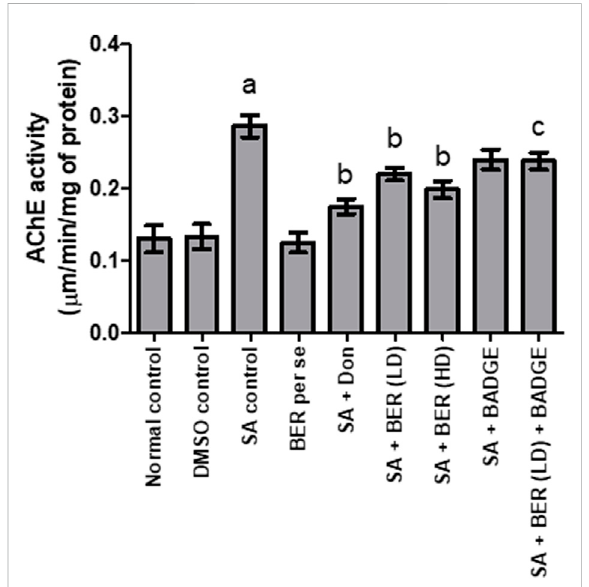
FIGURE 3 Effect of pharmacological interventions on brain AChE activity ( μ M of ACh hydrolyzed/min/mg protein). “ DMSO, dimethyl sulfoxide; SA, sodium azide; Don, donepezil; BER, bergenin; BER (LD), bergenin low dose; BER (HD), bergenin high dose; BADGE, Bisphenol A diglycidyl ether ” (Mehra et al., 2015). “ Each group ( n = 6) represents mean ± S.E.M, a = p ˂ 0.05 vs. normal control, b = p ˂ 0.05 vs. normal control, c = p ˂ 0.05 vs. SA control. One way ANOVA followed by Bonferroni ’ s multiple range test ” (Gulati and Singh, 2014).